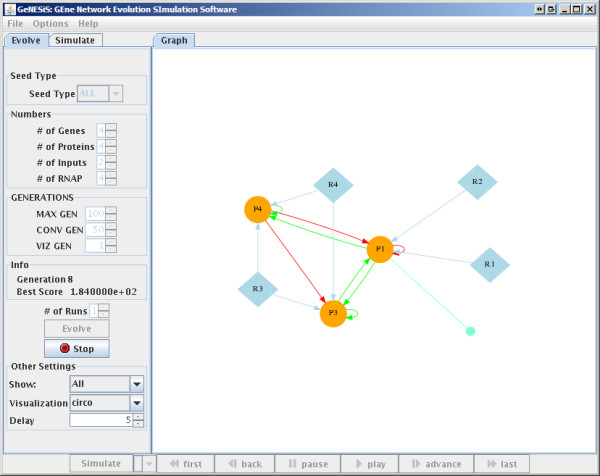
Evolution Window.